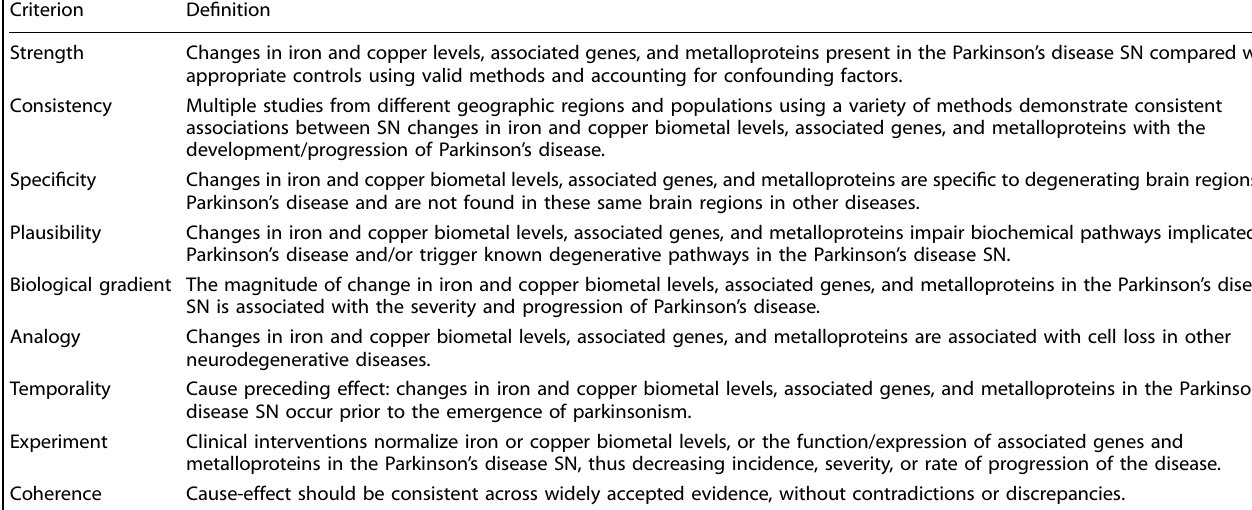
Table 1. Criteria proposed by Bradford Hill and the de fi nitions used in the current work to evaluate evidence for causality between changes in iron and copper and Parkinson ’ s